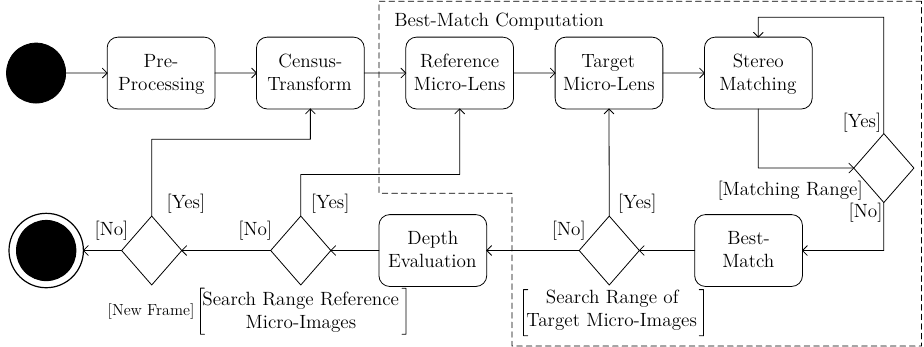
Figure 4. UML activity diagram of the modified depth estimation